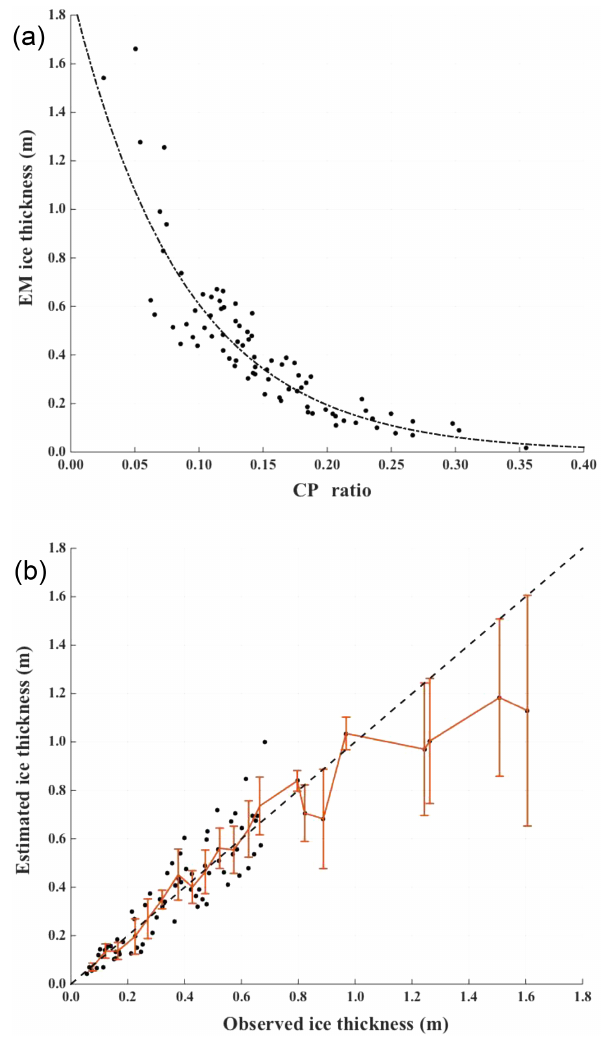
Figure 11. (a) Relationship between the CP ratio and the observed EM sea thickness. (b) Comparison between the observed and esti- mated ice thicknesses, and the error bars show the standard devia- tion with respect to the observation data for every 0.05m segment of ice